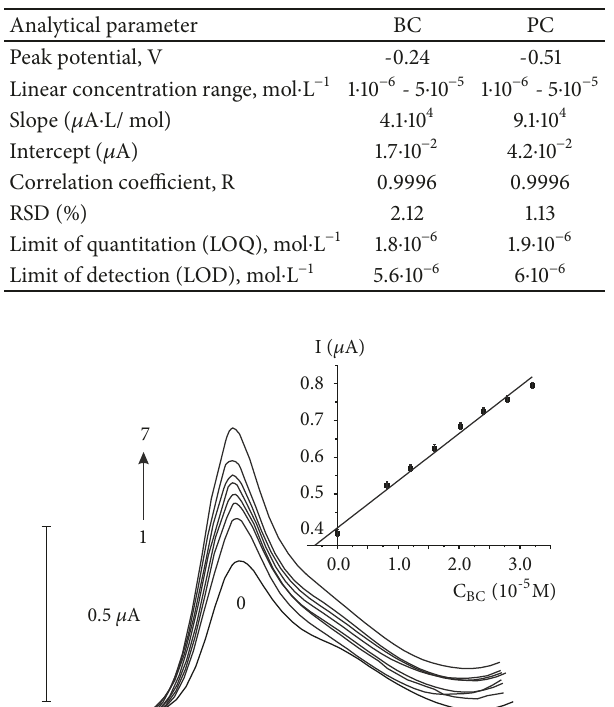
Table 4: Characteristics of quantitative polarographic determina-